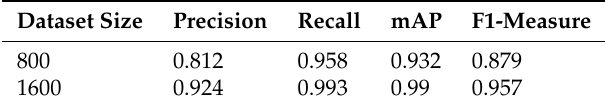
Figure 8. The predicted categories and confidence scores of continuous signs. Table 3. The recognition results of different dataset sizes.